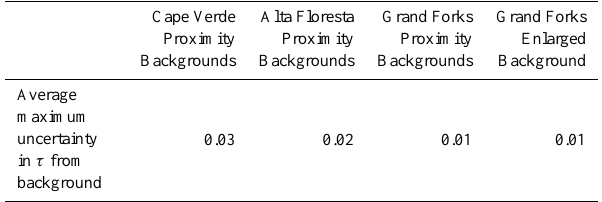
Table 1. Average maximum uncertainties in retrieved τ due to dif- ferent background samples spaced at various distances from the artificial light sources (proximity backgrounds). Also, for Grand Forks, average maximum uncertainty in retrieved τ due to the use of different-sized background samples (enlarged